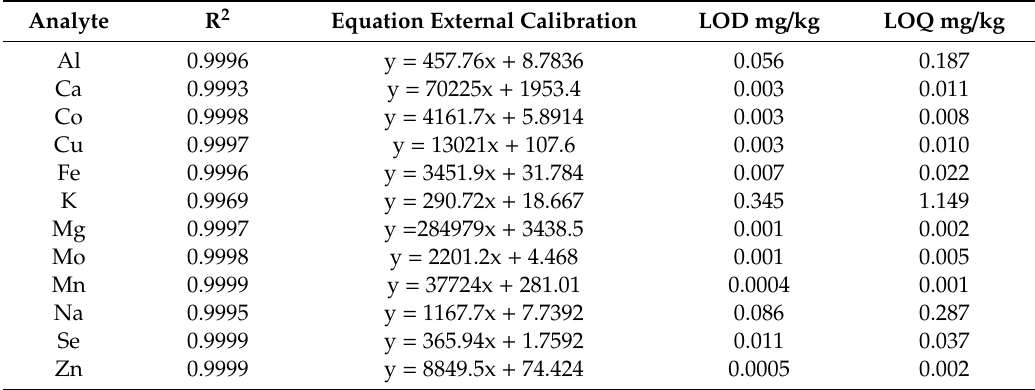
Table 1. Parameters of calibration curves obtained by external calibration, correlation coe ffi cient (R 2 ), the limit of detection (LOD) and limit of quantification (LOQ) by using ICP